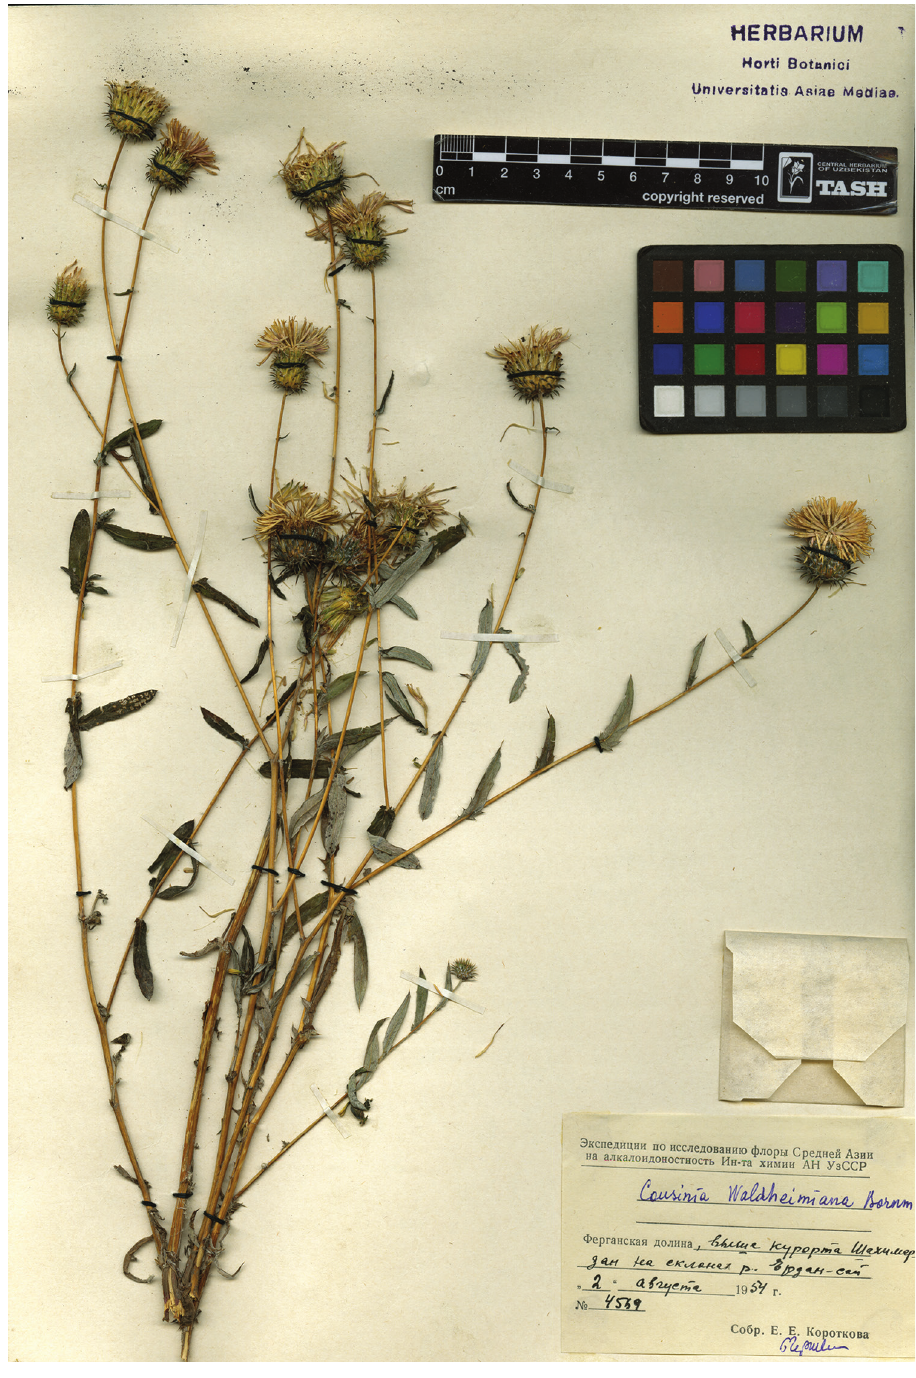
Figure 1. Representative specimen of C.